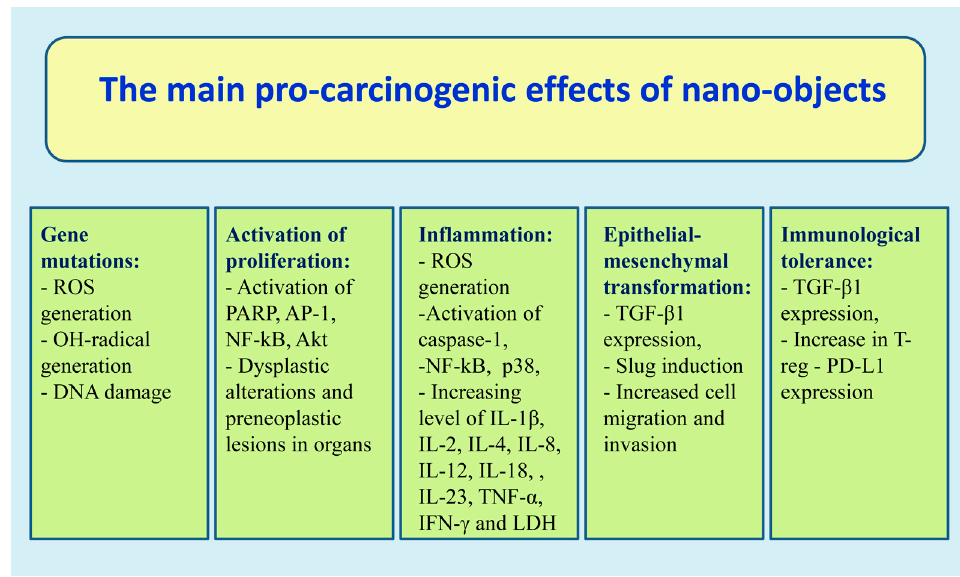
Figure 2. The main pro-carcinogenic effects of nano-objects.